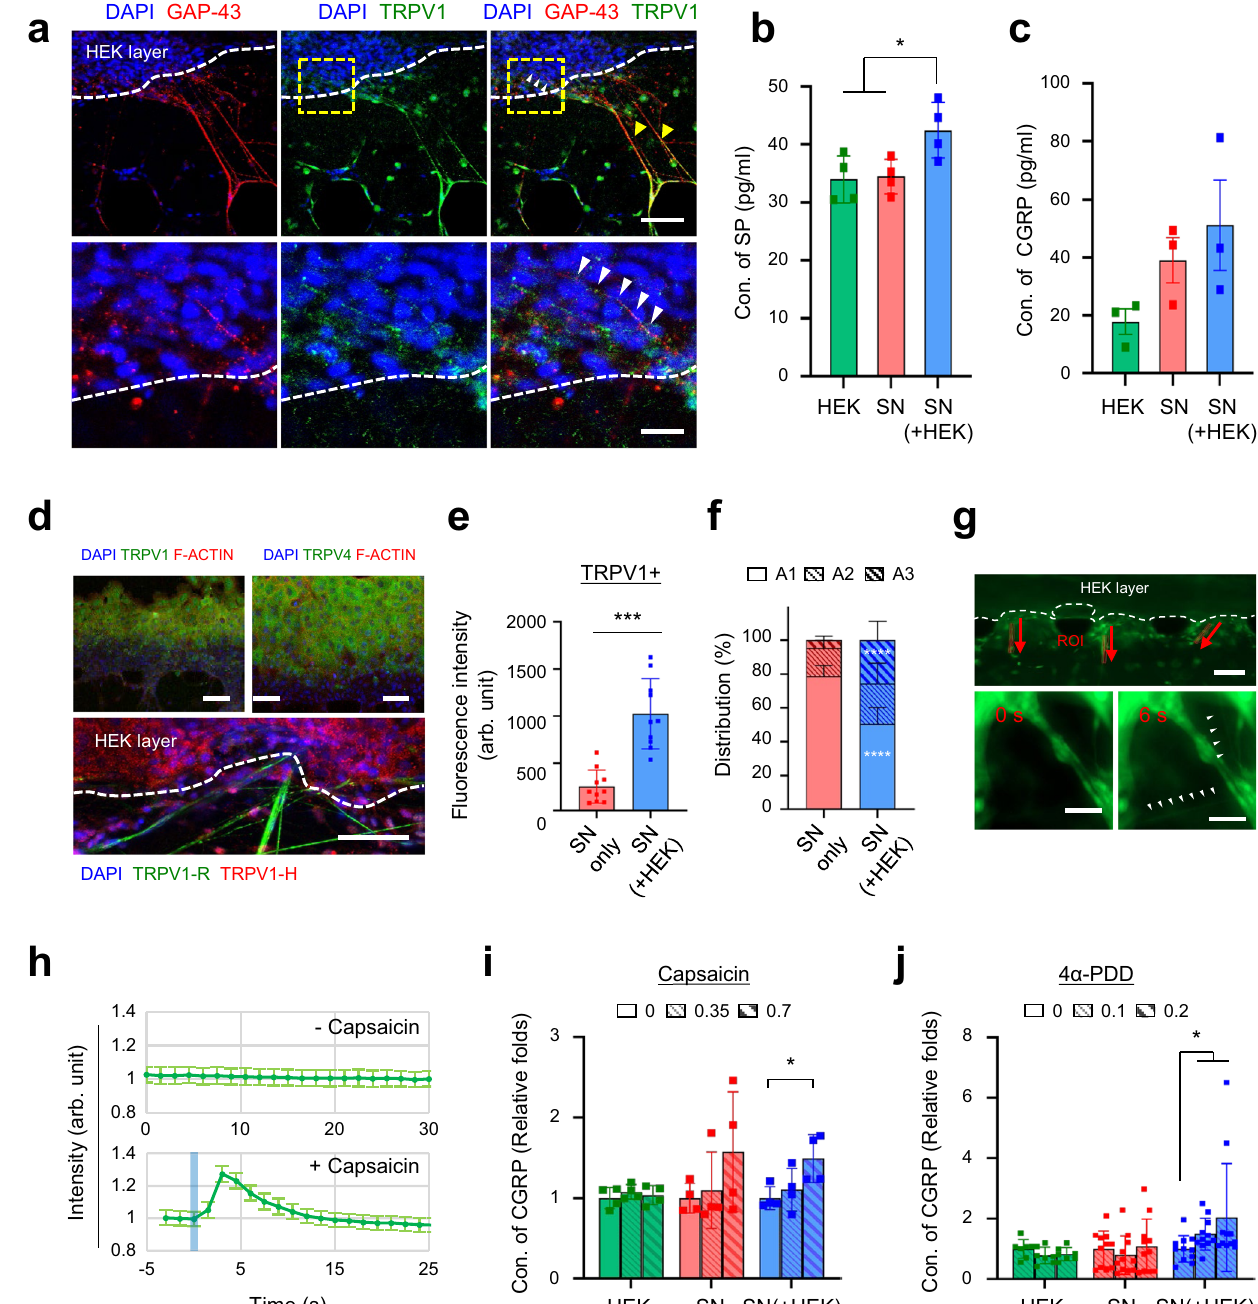
Fig. 5 | Functional integrity of the innervated epidermal-like layer in the micro fl uidic chip. a Representative immuno fl uorescence images of TRPV1 (green) and GAP-43 (red) expression in sensory neurons co-cultured with kera- tinocytes on a chip. Arrowheads indicate TRPV1 + cells co-stained with GAP-43 in either the outer epidermal and ECM layers (yellow) or the intraepidermal layer (white). White dashed line; the outer epidermal layer. Magni fi cations (bottom) of the region are highlighted in the yellow dashed box (top). Scale bars; 100 μ m, 25 μ m, respectively (1 independent replicate). b , c Quanti fi cation of neuropep- tides released from HEK only, SN only, and SN+HEK group under unstimulated conditions. The concentration of substance P ( n =4 devices, SN+HEK vs HEK * p =0.036, SN+HEK vs SN * p =0.0248, 2 independent replicates) ( b ) or CGRP ( n =3 independent replicates, mean±SEM) ( c ) is determined in culture super- natants. d – f TRPV1 and TRPV4 expression in the innervated epidermal chip. Representative immuno fl uorescence images (top of d ) of epidermal keratino- cytes TRPV1 or TRPV4 (green) and F-ACTIN (red) expression. TRPV1 expression (bottom of d ) was con fi rmed with a human-speci fi c antibody (TRPV1-H, red) or